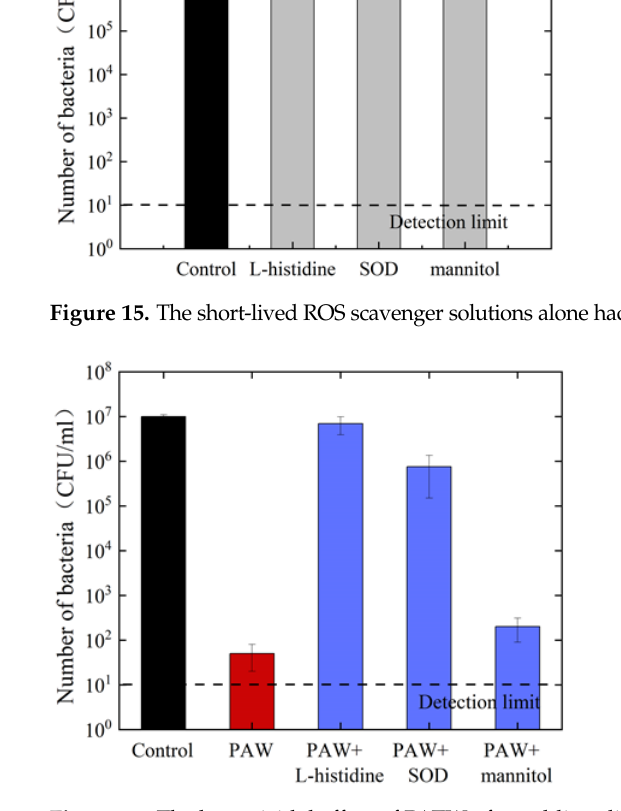
Figure 16. The bactericidal effect of PATW after adding different scavengers.